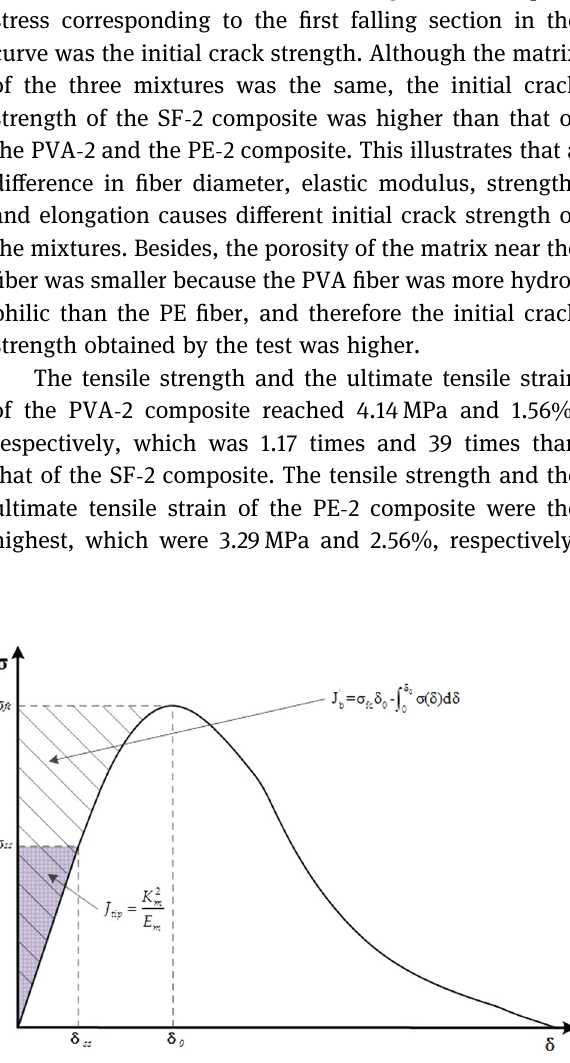
Figure 12: Typical σ – δ curve of the cement - based